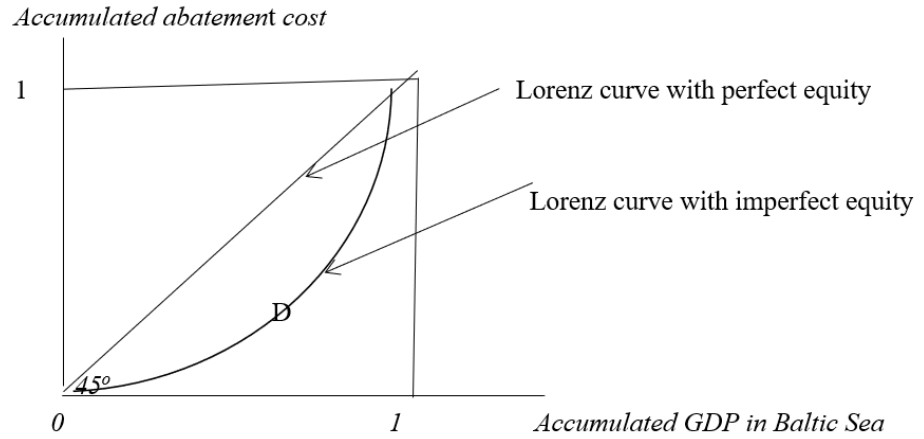
Figure 1. Illustration of Lorenz curves for perfect and imperfect equity with respect to allocation of abatement cost in relation to gross domestic product (GDP) among countries.